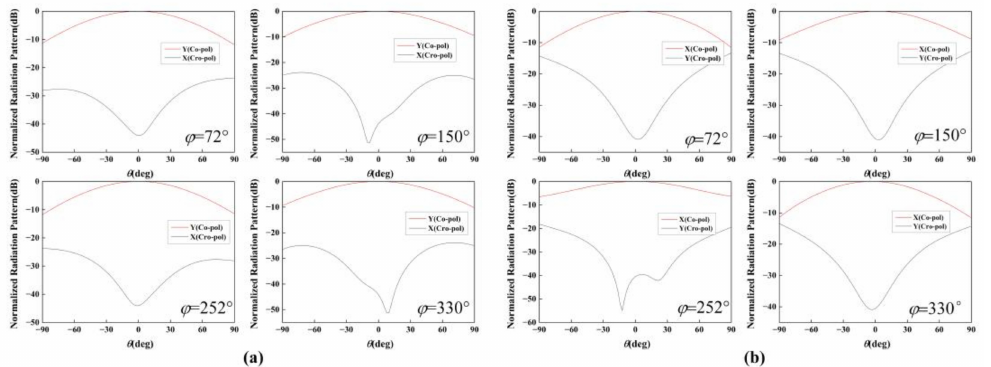
Figure 4. Normalized co-polarization and the cross-polarization patterns for LP element when the ( a ) sub-element A and ( b ) sub-element B working in φ = 72 ◦ , 150 ◦ , 252 ◦ , 330 ◦